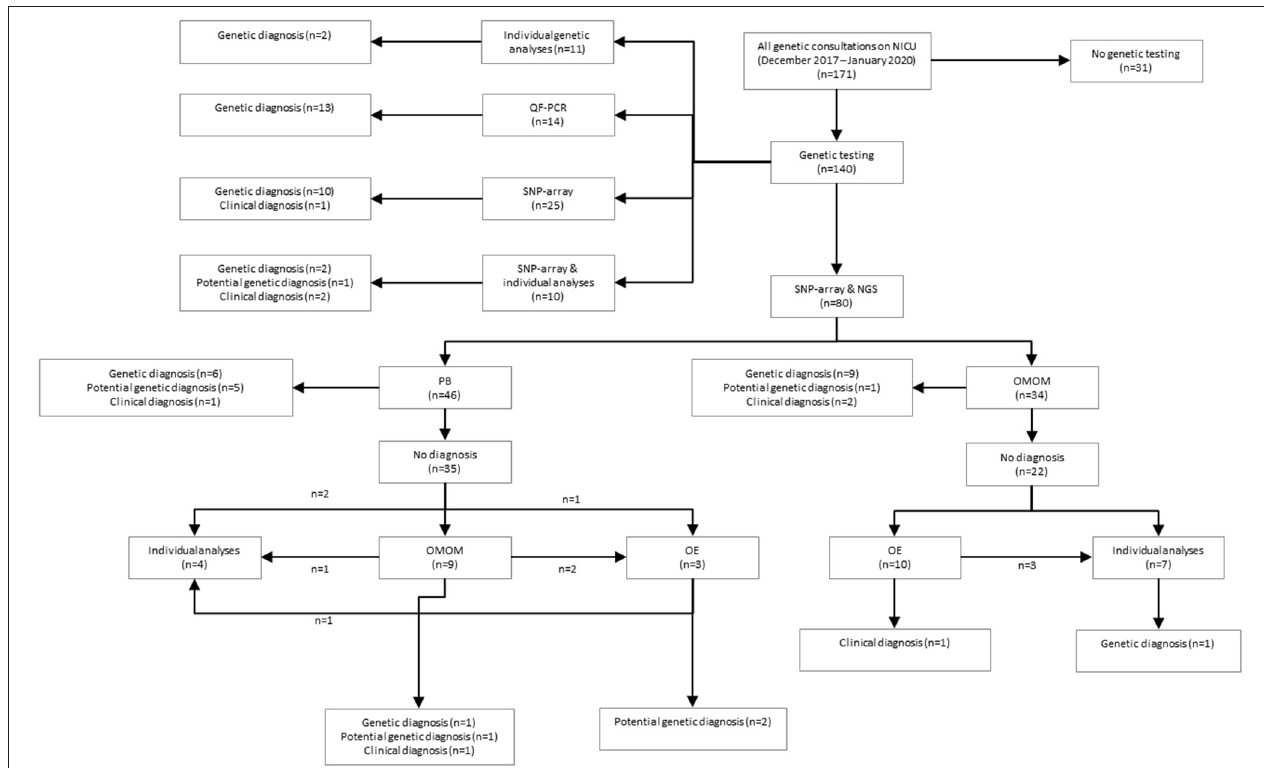
FIGURE 1 | Schematic overview of study results. QF, quantitative fluorescent polymerase chain reaction; SNP, single nucleotide polymorphism array; NGS, next-generation sequencing; PB, phenotype-based targeted sequencing, OMOM, OMIM mendelian targeted sequencing; OE, open-exome analysis.